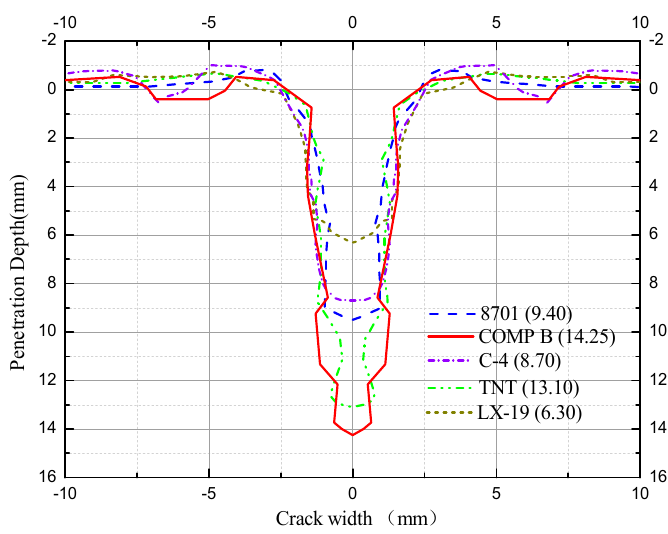
Figure 13. Penetration depth of BLSCs with different explosives.